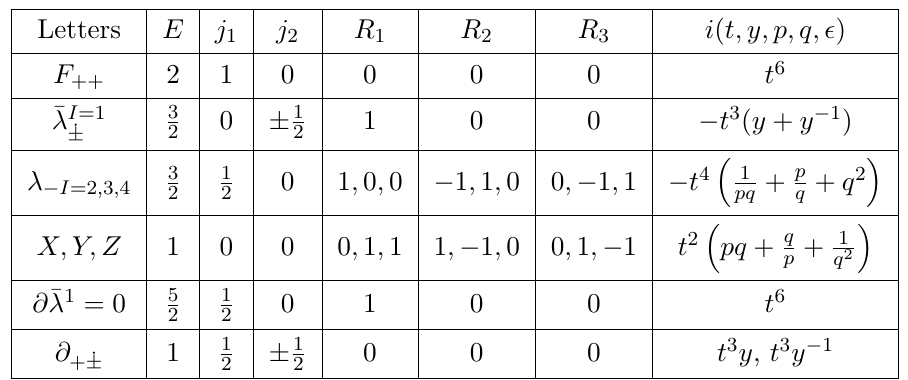
, (cid:21) (cid:11)I , _ (cid:11) _ (cid:12)